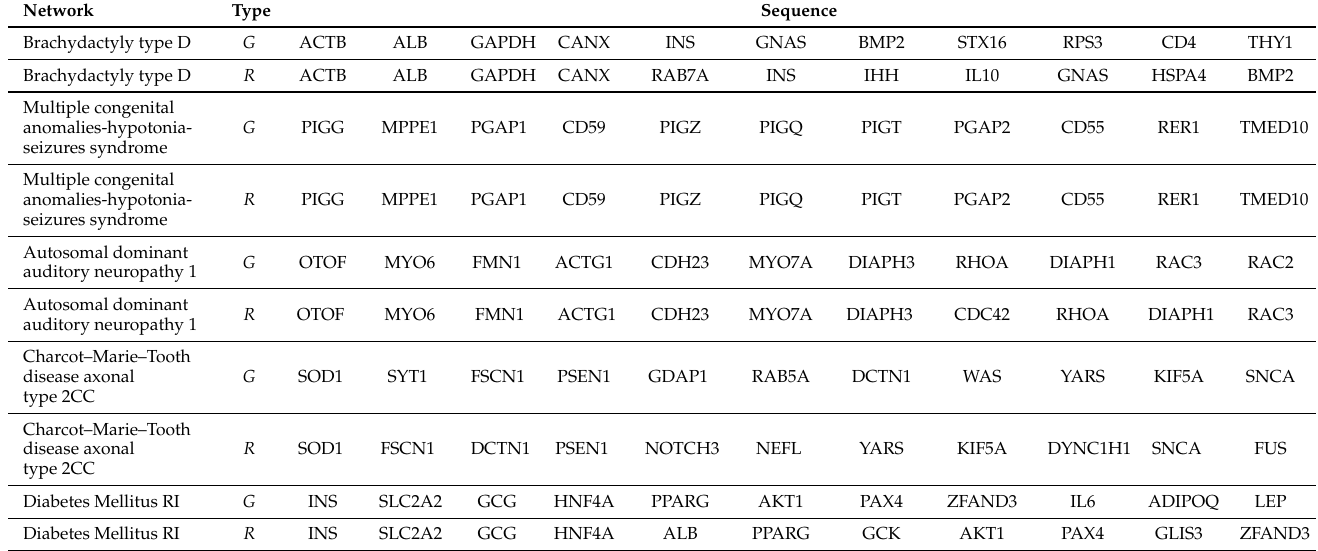
Table 6. Examples of generated sequences (G) and real ones (R). Only the first eleven proteins are shown to simplify the